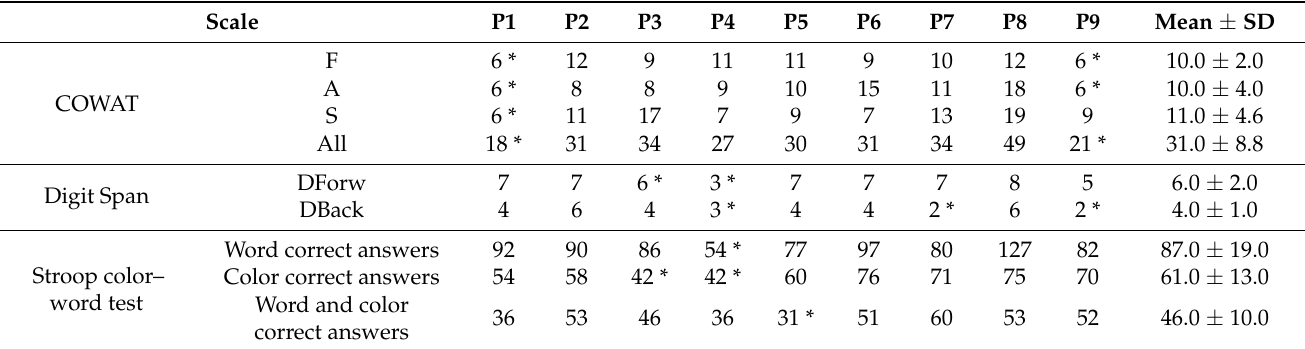
Table 4. COWAT, Digit Span (DForw and DBack) test and Stroop color–word test—correct answers (* lowest scale scores).